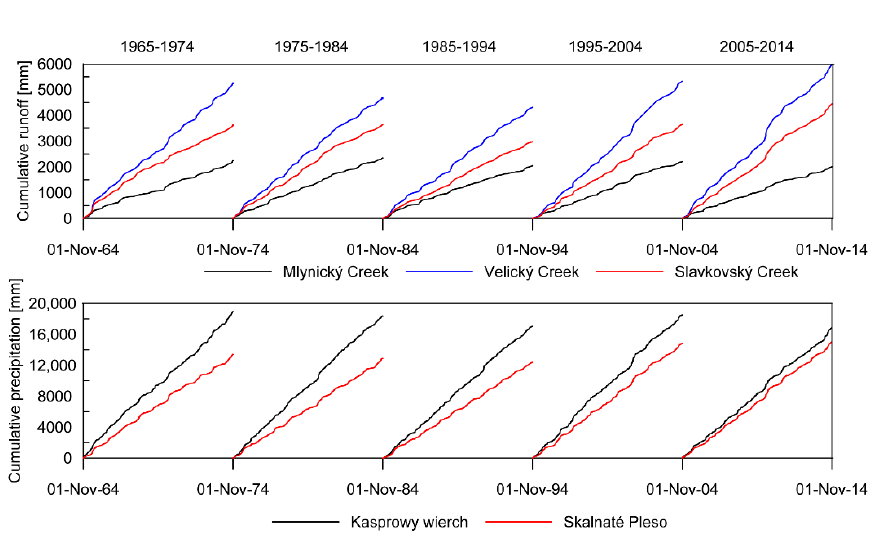
Figure 7. Cumulative runo ff and precipitation in decades from 1965–1974 to 2004–2014; precipitation data adopted from Holko et al., 2020.